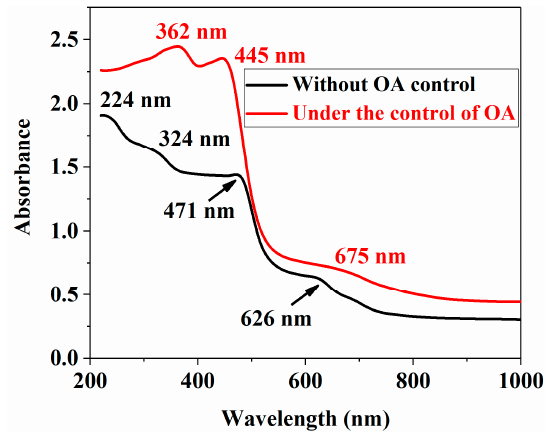
Figure 6. The UV-vis absorbance spectra of the DAST single crystals grown with and without the OA control.